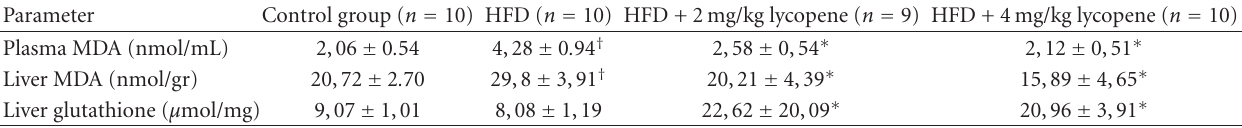
Table 3: The e ff ects of lycopene supplementation on MDA and glutathione levels in groups. Parameter